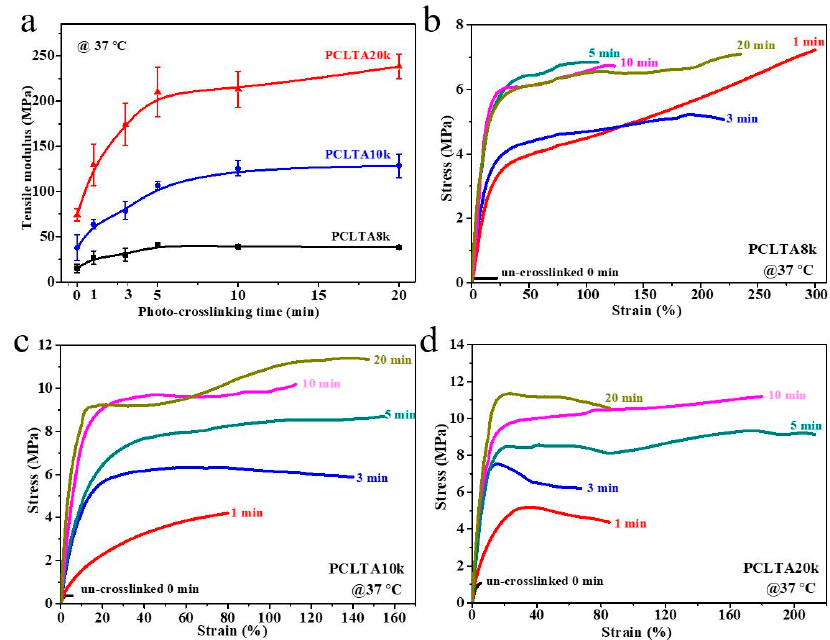
Figure 3. ( a ) Tensile modulus of PCLTAs (8k, 10k, and 20k) with different crosslinking time. Tensile stress–strain curves of PCLTAs (( b ), 8k; ( c ), 10k; ( d ), 20k) with different crosslinking time.